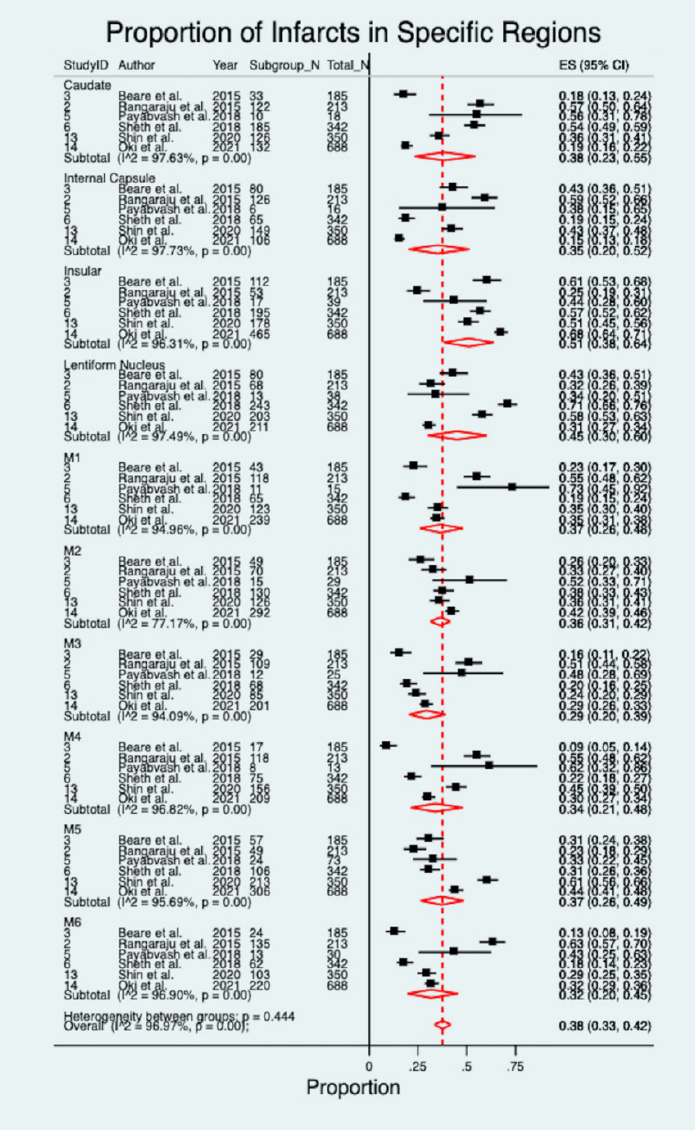
Figure 2. Proportion of infarcts in specific regions [15,17,18,20,27,28] .